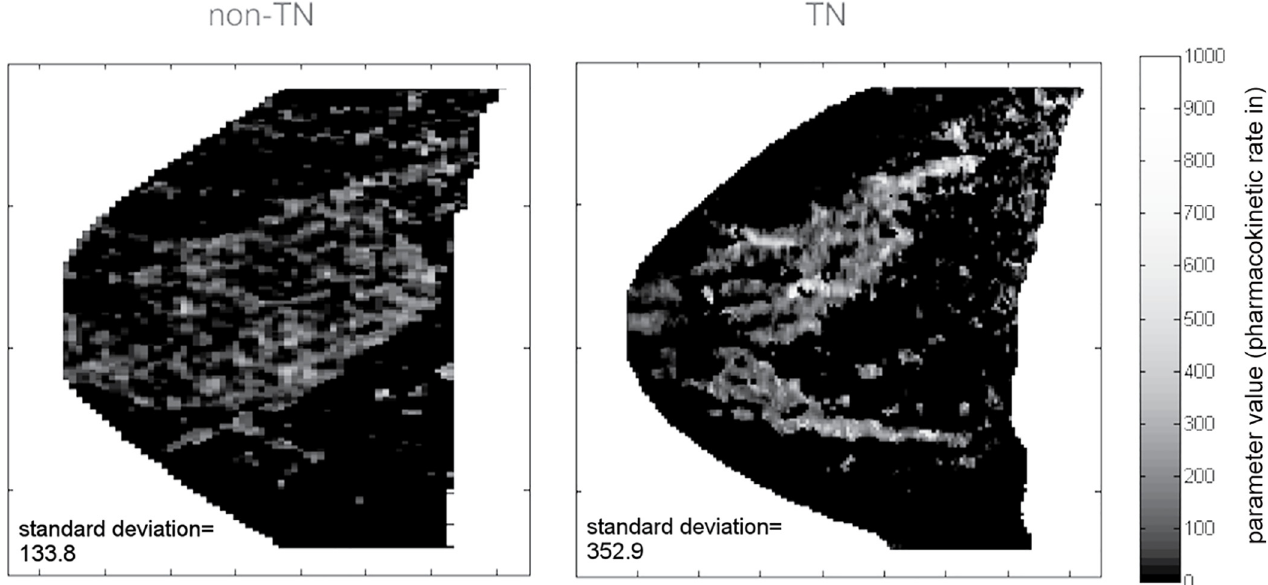
Fig 4. Examples of ‘ parenchyma rate in ’ parameter (also Fig 3B) maps from a non-triple-negative (TN) patient (left) and a TN patient (right) illustrating the difference of a statistical texture feature between members of the two groups in image form. Slices of the ‘ parenchyma rate in ’ parameter map void of tumor tissue are presented in the sagittal plane. It is evident the variation of this background parenchymal enhancement texture feature ’ s value is greater in TN cancers, where standard deviation is markedly higher at 352.9 as opposed to 133.8 in the non-TN patient.